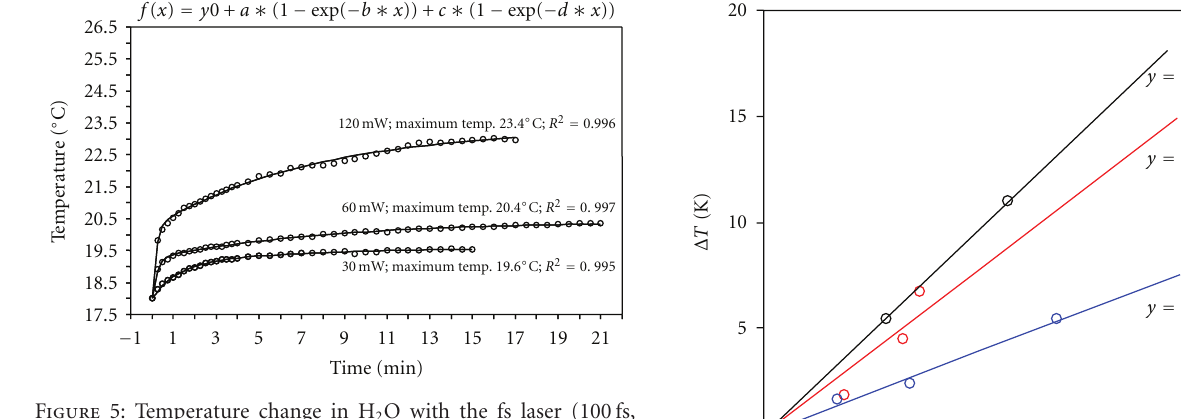
Figure 5: Temperature change in H 2 O with the fs laser (100 fs, 3Hz).